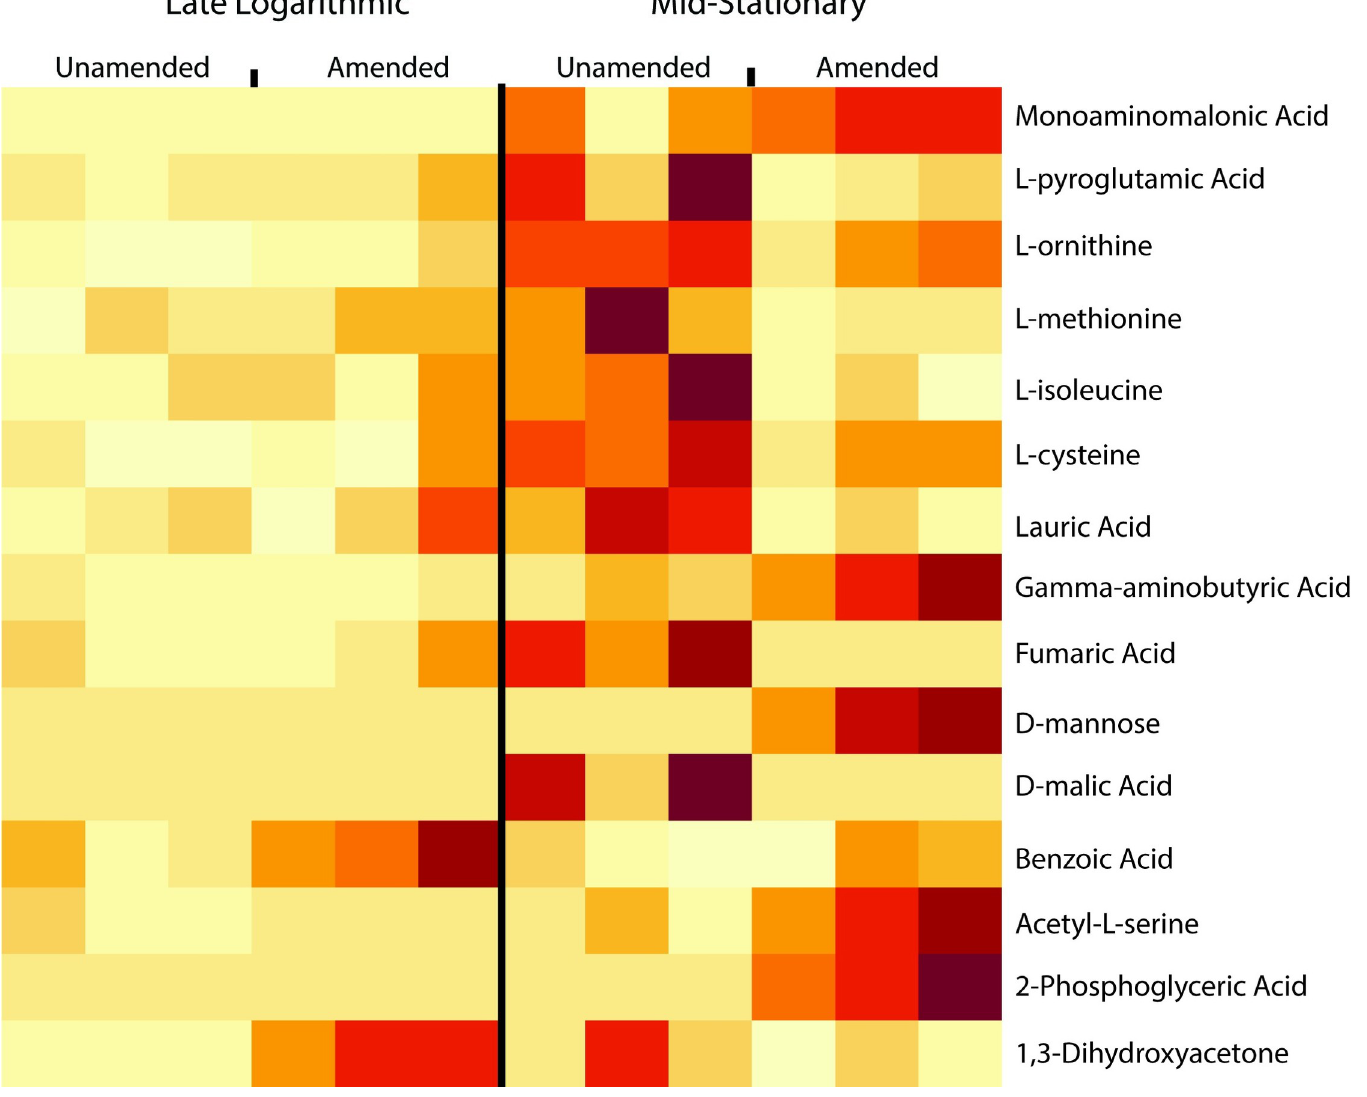
PLOS ONE | https://doi.org/10.1371/journal.pone.0233823 September 17, 2020 8 /